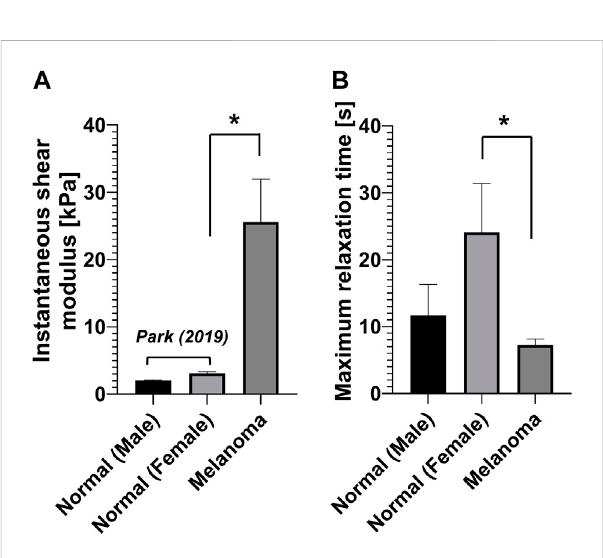
FIGURE 3 Viscoelastic properties of human normal (Park et al., 2019) and melanoma skin tissues. (A) Instantaneous shear modulus. (B) Maximum relaxation